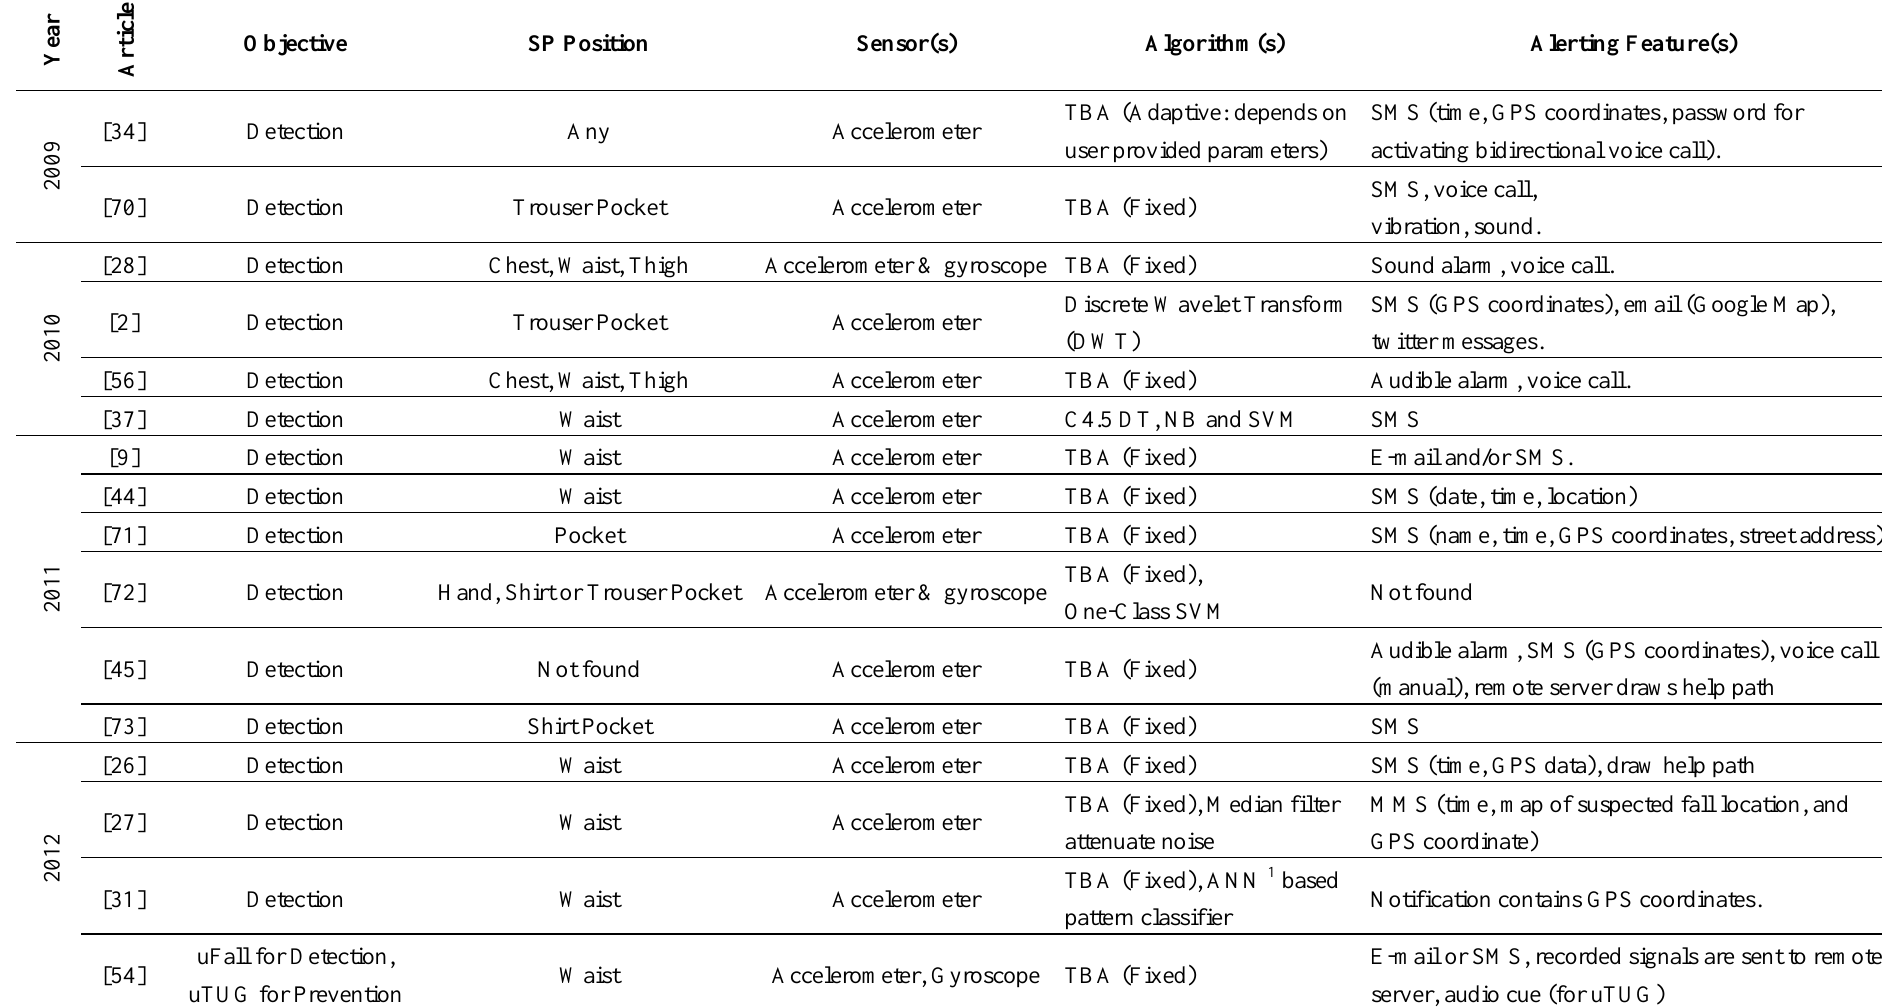
Table 2. Comparison of smartphone-only fall detection and prevention